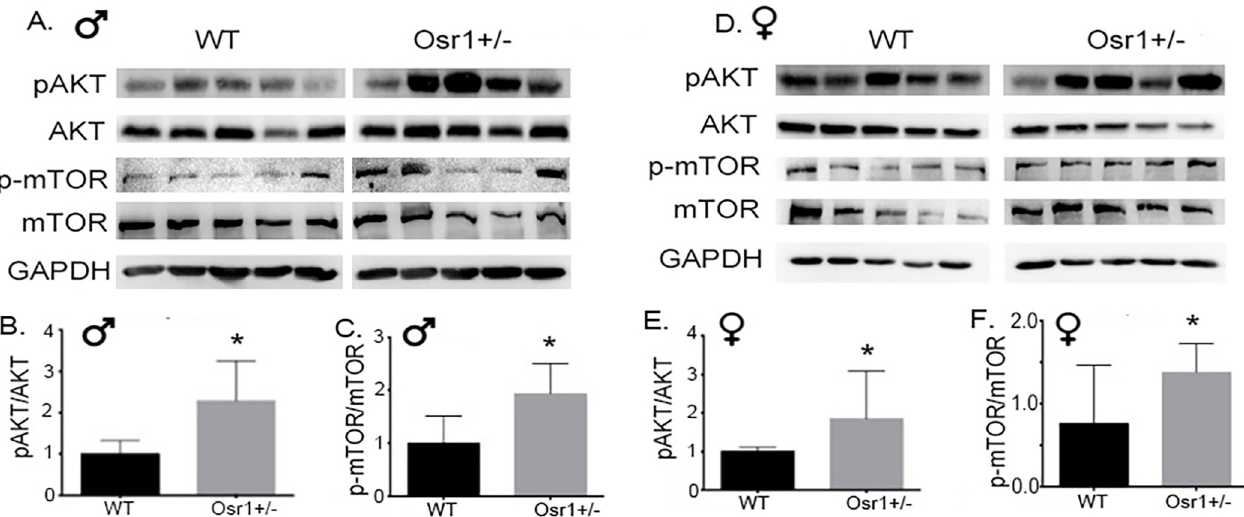
Fig 5. Osr1 heterozygous mice overactivated AKT and mTOR signaling in liver. (A). Immunoblot of hepatic Akt, p-AKT, mTOR and p-mTOR in male mice. (B) Osr1 heterozygous male mice had elevated p-AKT/AKT compared to WT male mice. (B). Osr1 heterozygous male mice had elevated p-mTOR/ mTOR compared to WT male mice. (C). Immunoblot of hepatic Akt, p-AKT, mTOR and p-mTOR in female mice. (D). Osr1 heterozygous female mice had elevated p-AKT/AKT compared to WT female mice. (E). Osr1 heterozygous female mice had elevated p-mTOR/mTOR compared to WT female mice. Data is presented as Mean ± SD, N = 5; � p <